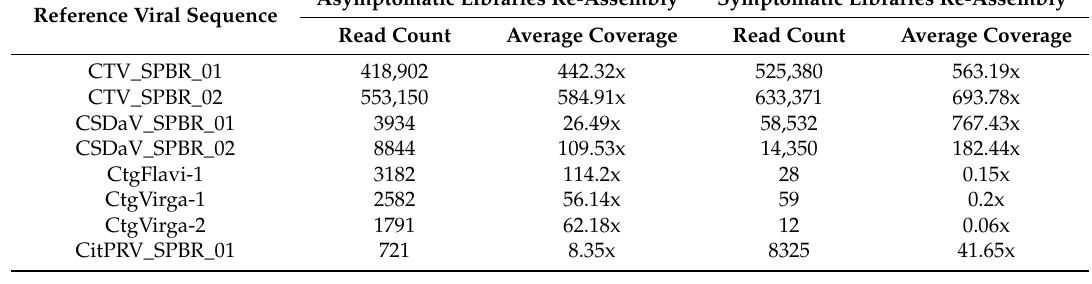
Table 6. Re-assembly data among different viral sequences identified in this study by mapping reads from asymptomatic and symptomatic combined libraries for comparative analysis. Read count and average coverage are shown for each viral sequence.